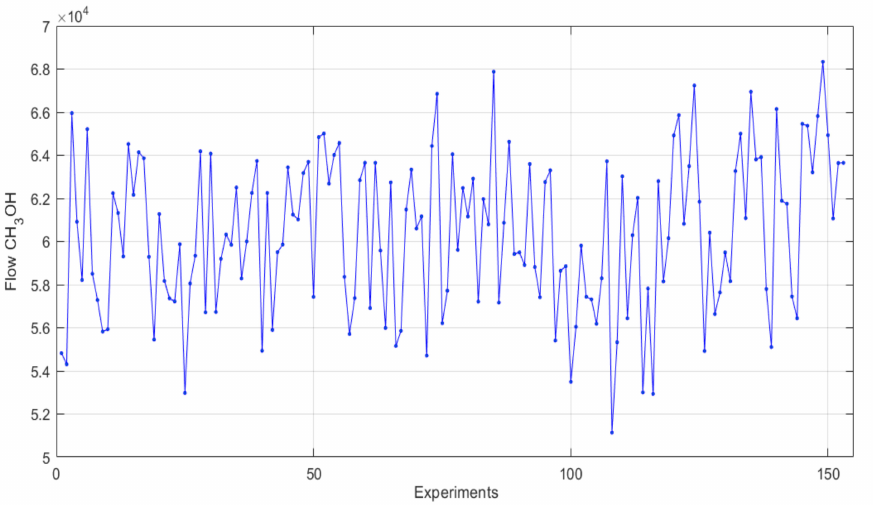
Figure 5. Outlet values (flow CH 3 OH) employed to training, validation and testing the